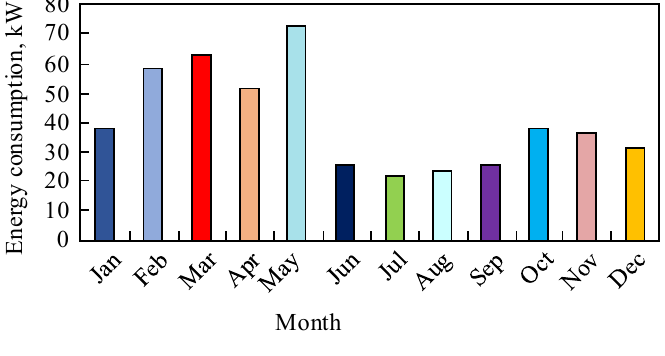
Fig. 9. Hydrogen produced by electrolyser in different months.